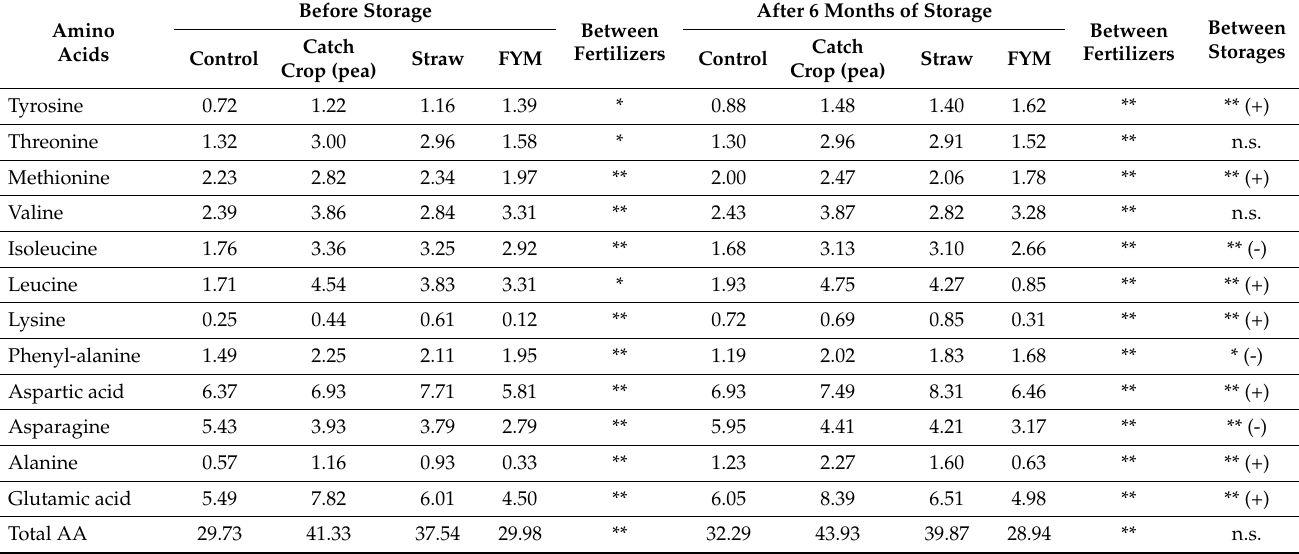
Table 11. Effect of organic fertilization and storage on the amino acid composition of potato tubers (g 100 g − 1 protein) (mean from 3 years).